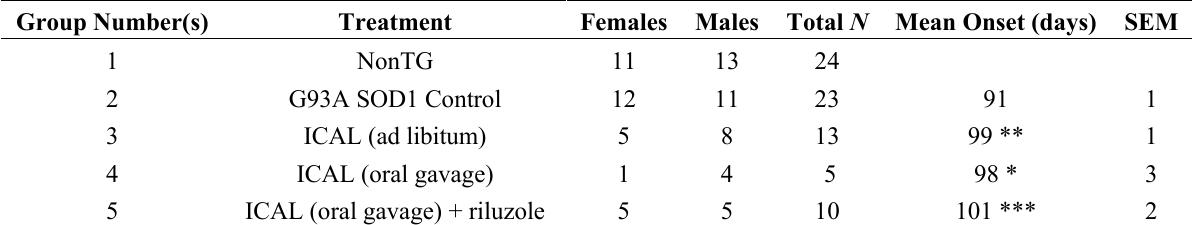
Table 3. Gender distribution of treatment groups and statistical analysis of disease onset. Group